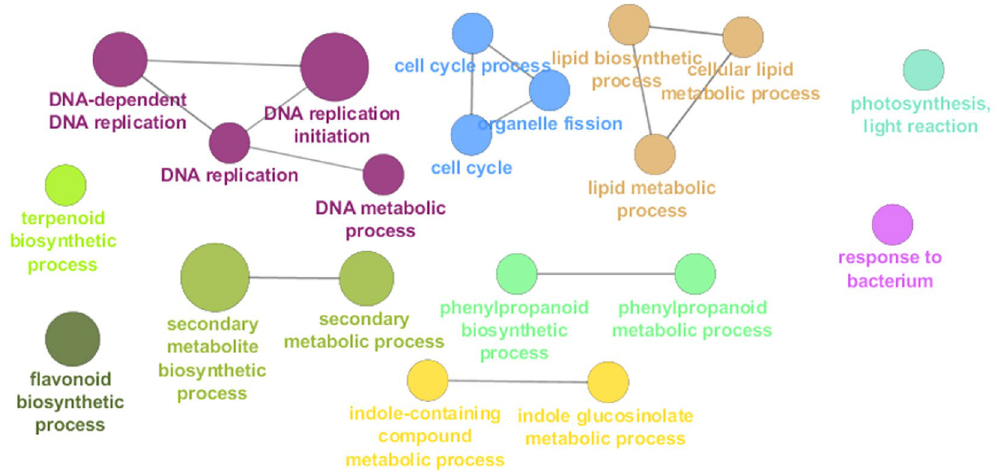
Figure 3. GOE analysis of the TOP region. Different colours indicate different ontologies. The bigger the circle, the higher the statistical